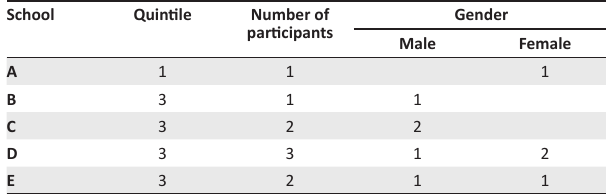
TABLE 2: School and gender breakdown of